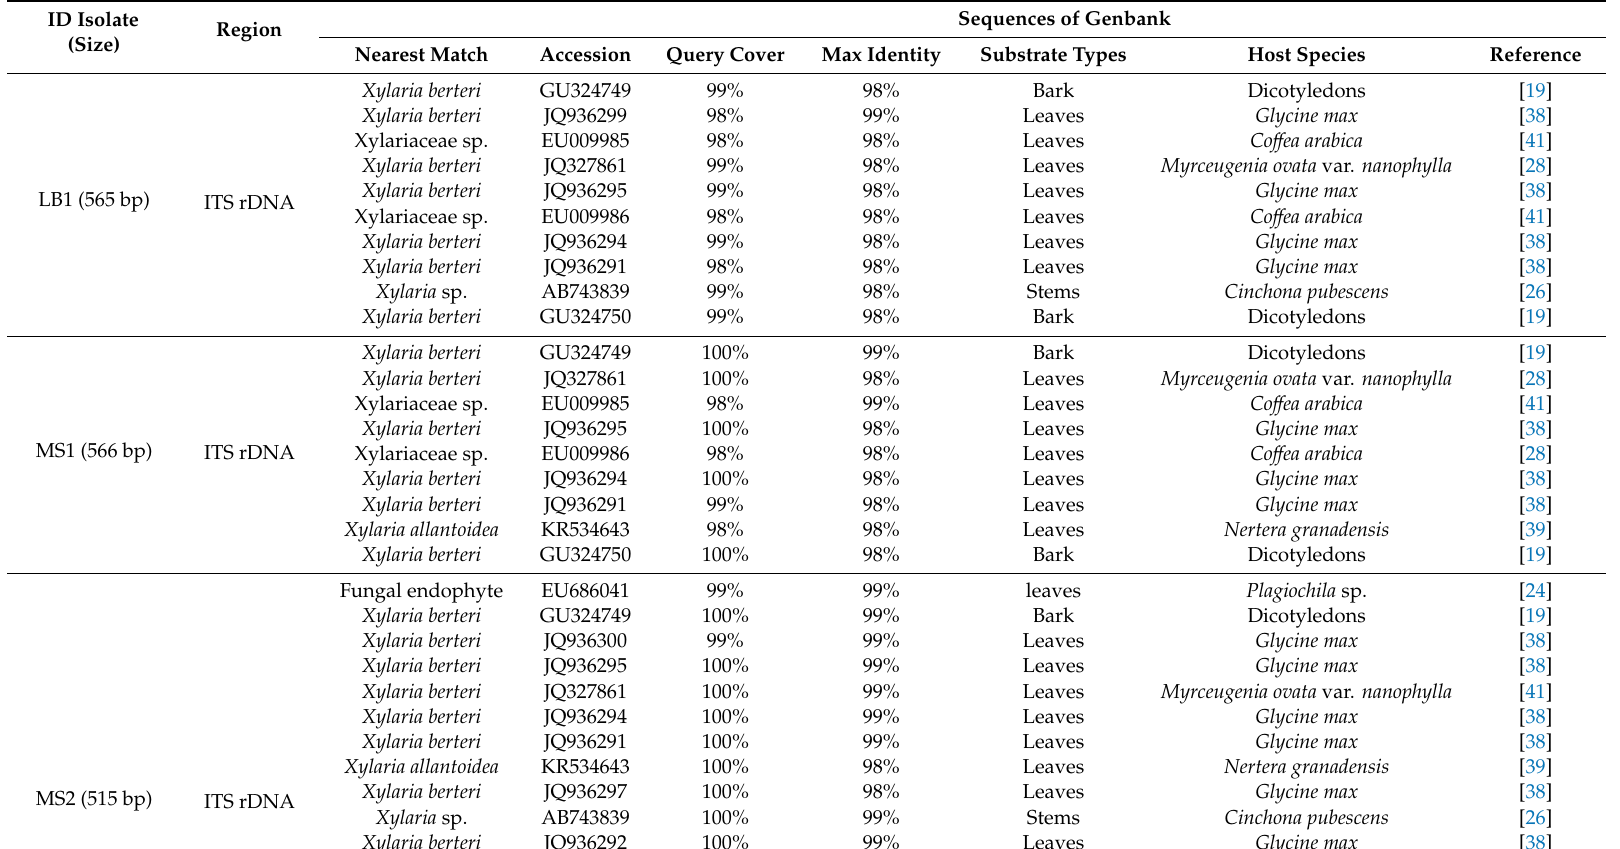
Table 1. Identification of fungal endolichenic isolated from Cladonia curta based on ITS region of rDNA and β -Tubulin gene sequences data comparison with sequences available in the Genbank database using BLASTn algorithm. Sequences of fungi of accession numbers JF773597, KP133344, JN418792, KC771483 and HQ117853 were not included; although they met the statistical significance the studies reporting these sequences have not yet been